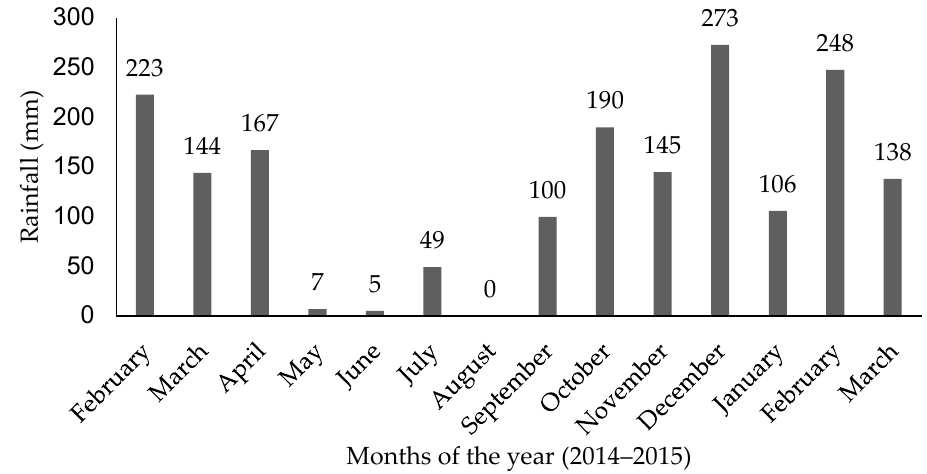
Figure 1. Monthly rainfall during the experiment.